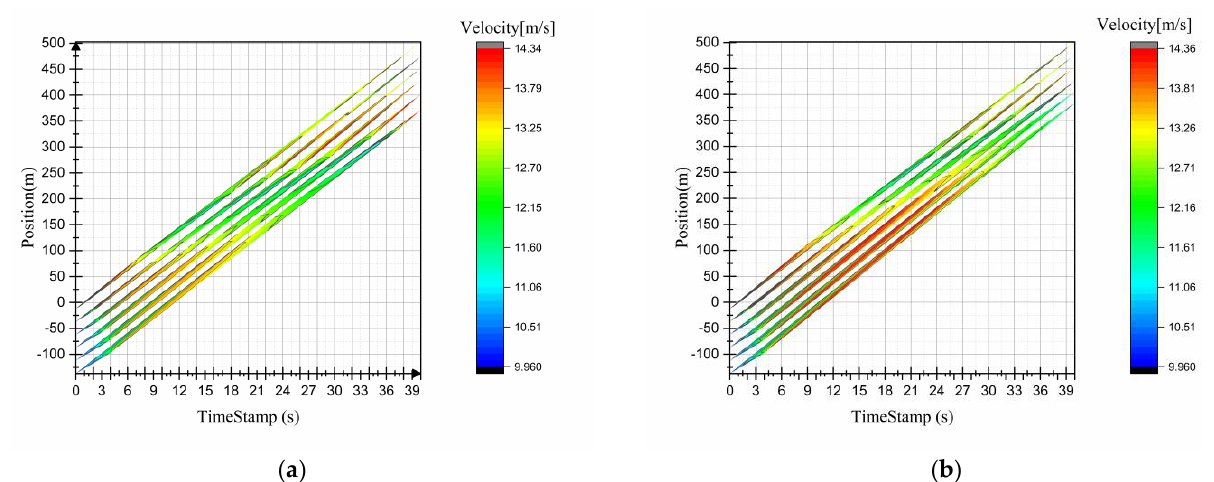
Figure 15. Velocity heatmaps of CAVF fleet and CACCNF fleet under scenario 3: ( a ) CAVF velocity heatmap; ( b ) CACCNF velocity heatmap.